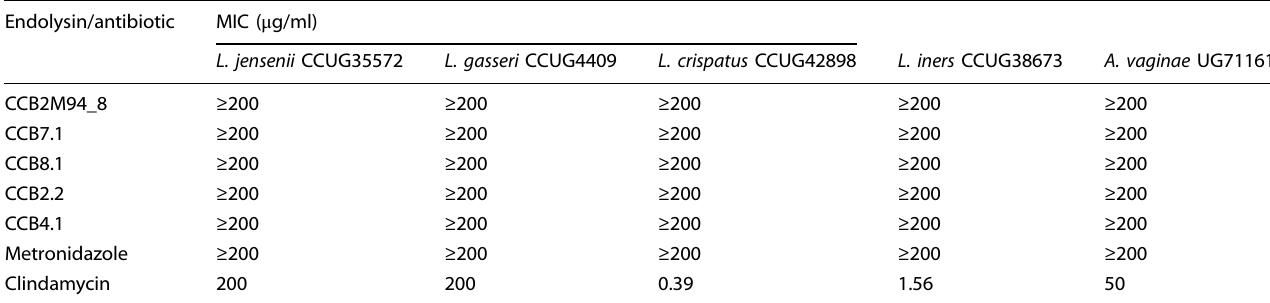
Table 4. MIC for fi ve different endolysin candidates, metronidazole and clindamycin against vaginal lactobacilli and A. vaginae .